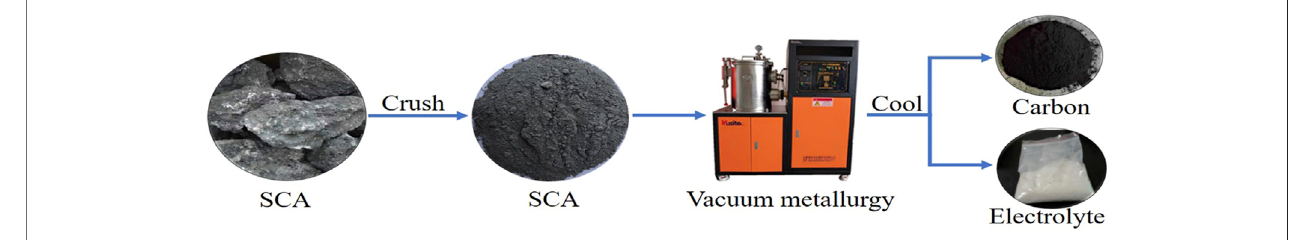
FIGURE 3 | SCA treatment via vacuum metallurgy.